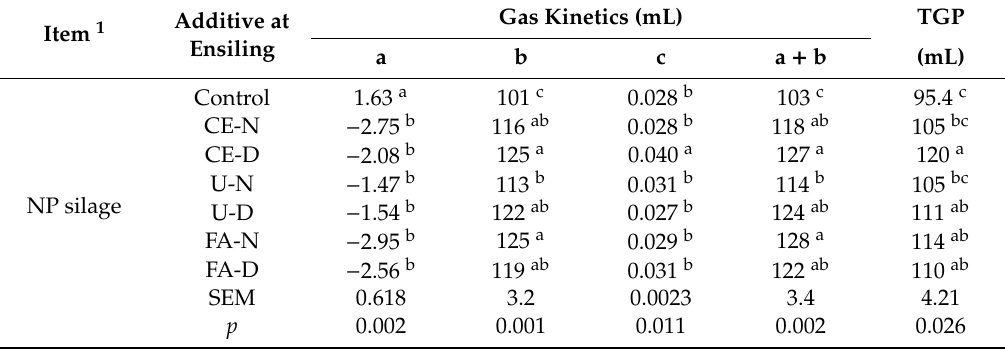
Table 7. Gas kinetics and total gas production after 96 h of incubation of silages after 30 d of